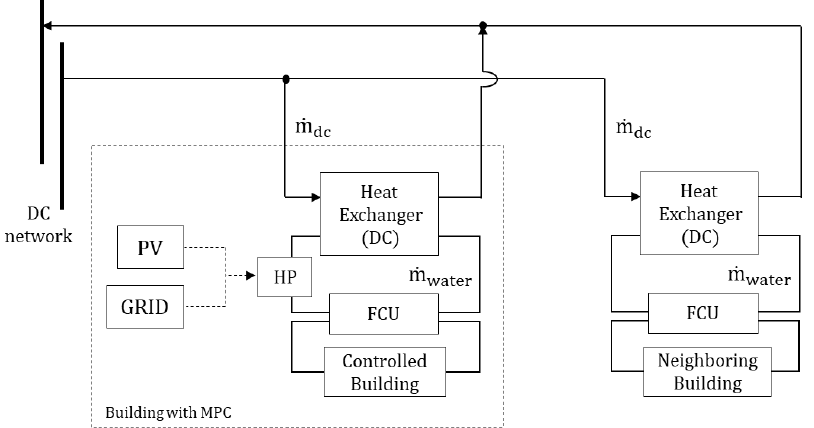
Figure 6. Focus on a portion of users connected to DC: the user on the left is the building controlled using the MPC, while the user on the right represents a neighboring building.